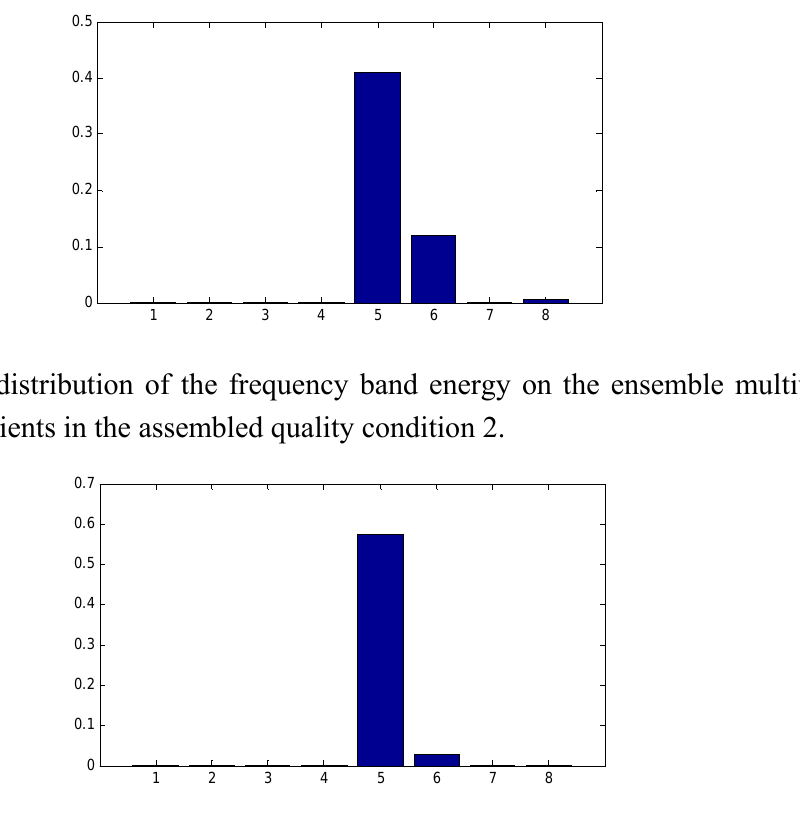
Figure 16. The distribution of the frequency band energy on the ensemble multiwavelet transform coefficients in the assembled quality condition 3. Table 1. The normalized ensemble multiwavelet transform information entropy of three assembled